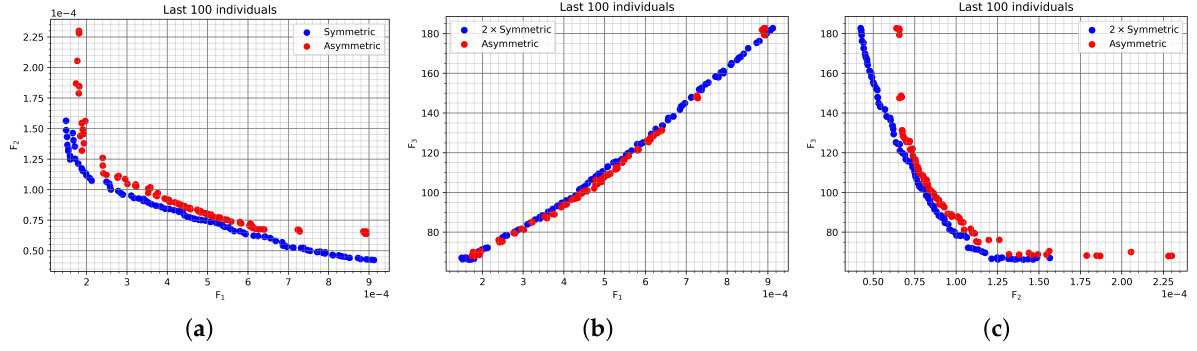
Figure 11. The last 100 individuals if the last generation is not sorted based on any of the conditions. These solutions are lying on the Pareto front. The blue dots show the symmetric setups, while the asymmetric solutions are depicted in red. ( a ) The distribution of individuals on the F 1 – F 2 axis. ( b ) The distribution on the F 1 – F 3 axis. ( c ) The distribution on the F 2 – F 3